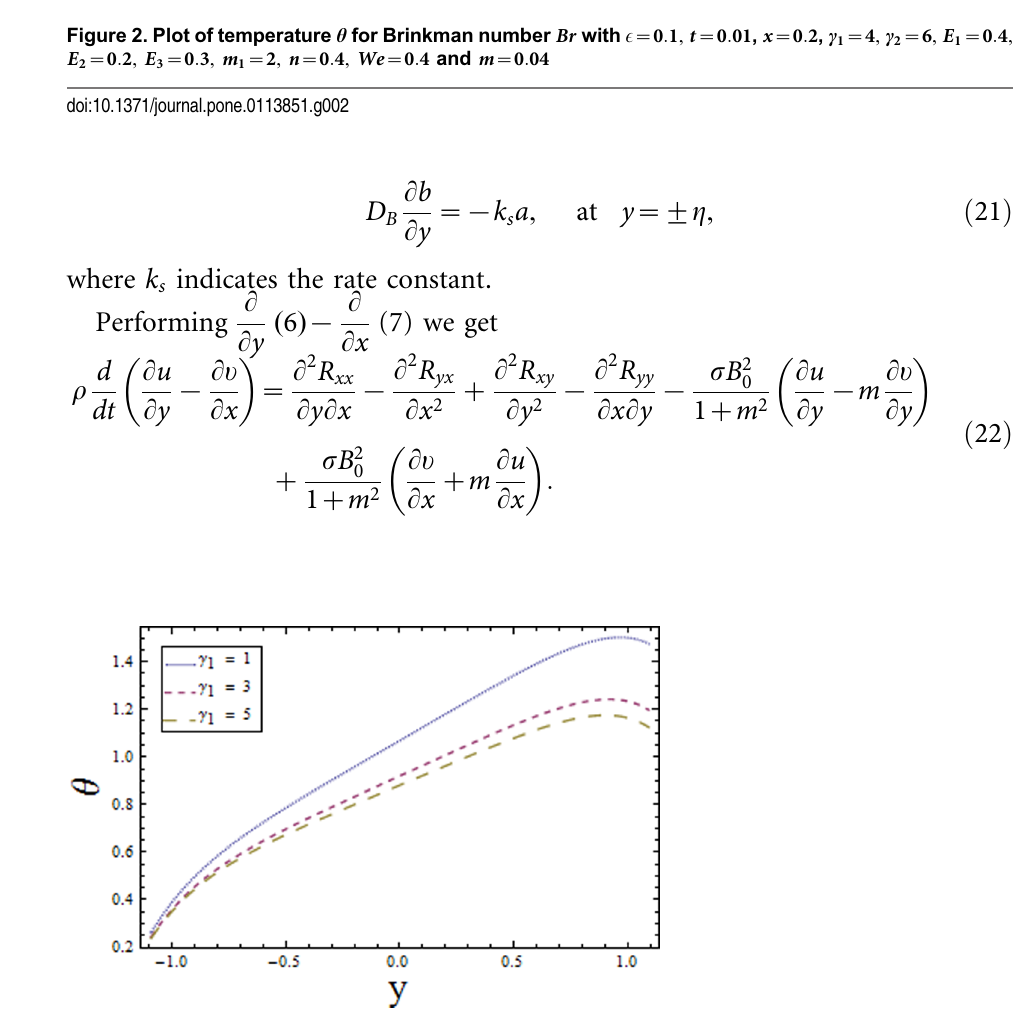
Figure 3. Plot of temperature h for Biot number ª 1 with E ~ 0 : 1 , t ~ 0 : 01 , x ~ 0 : 2 , Br ~ 1 , ª 2 ~ 6 , E 1 ~ 0 : 4 ,